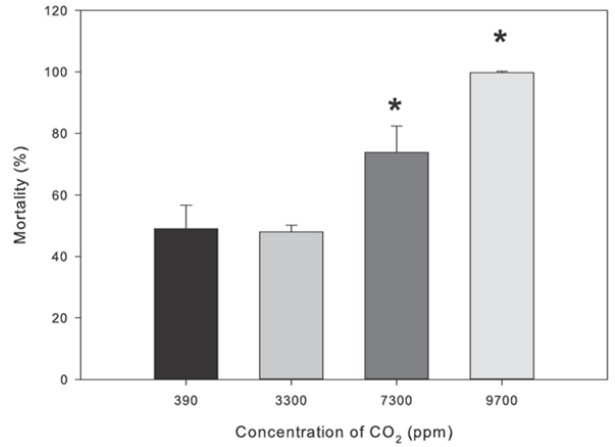
Fig. 2. Mortality recorded after 28-day exposure to different levels of CO 2 -acidified seawater. The bars show mean ± 1 std and signifi- cant differences between control (390ppm) and exposed groups are indicated by asterisks